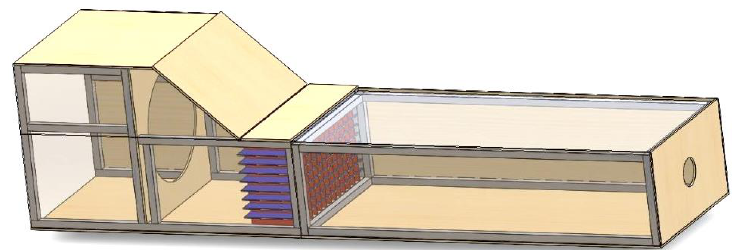
Figure 1. A 3D view of the proposed wind tunnel.